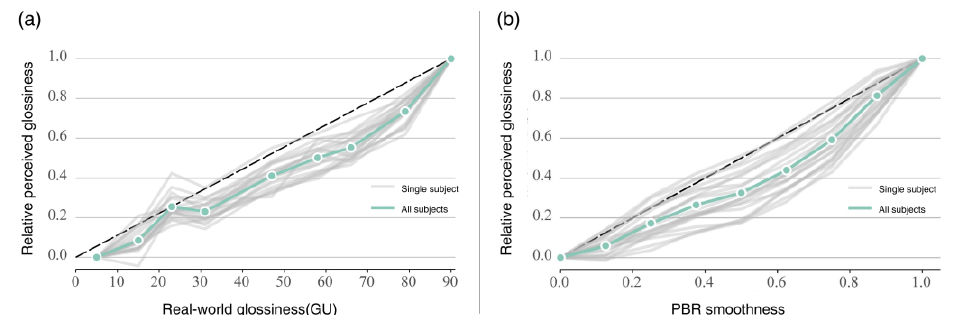
Figure 3. The results of the psychological scale were obtained by MLDS analysis. ( a ) The relationship between real-world glossiness and relative perceived glossiness. ( b ) The relationship between PBR smoothness parameters and relative perceived glossiness. The black dashed line in the figure is a reference, indicating the relative perception intensity that theoretically corresponds to no psychological perception influence.